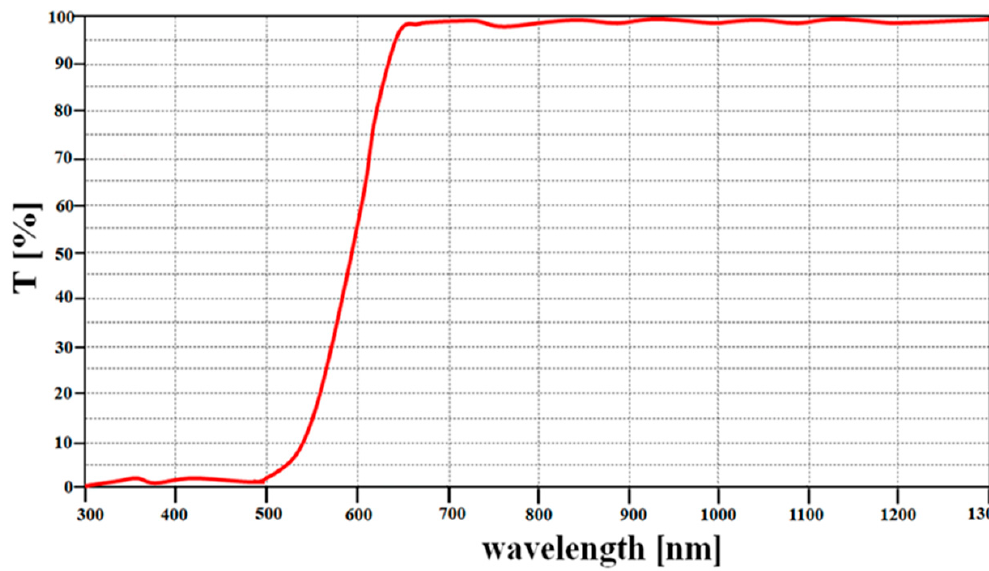
Figure 5. Measurement result of fabricated a long-pass filter.